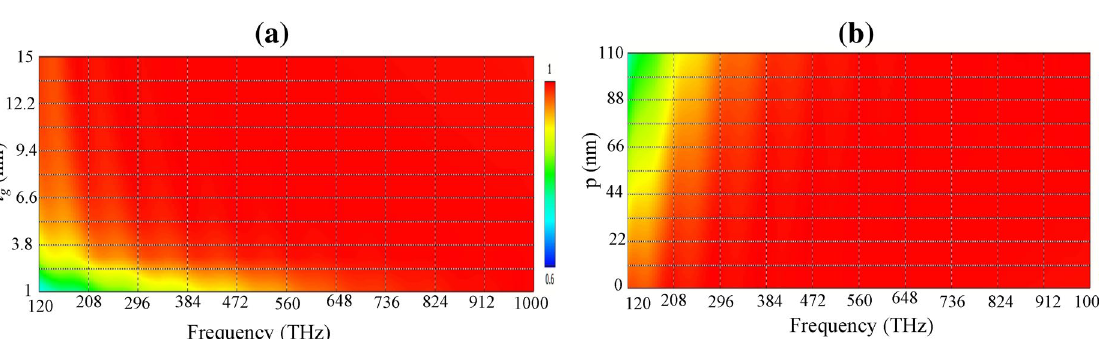
Figure 5. The absorption rate of the proposed solar cell when ( a ) filling the core with SiO 2 and ( b ) not truncating the cone tip.